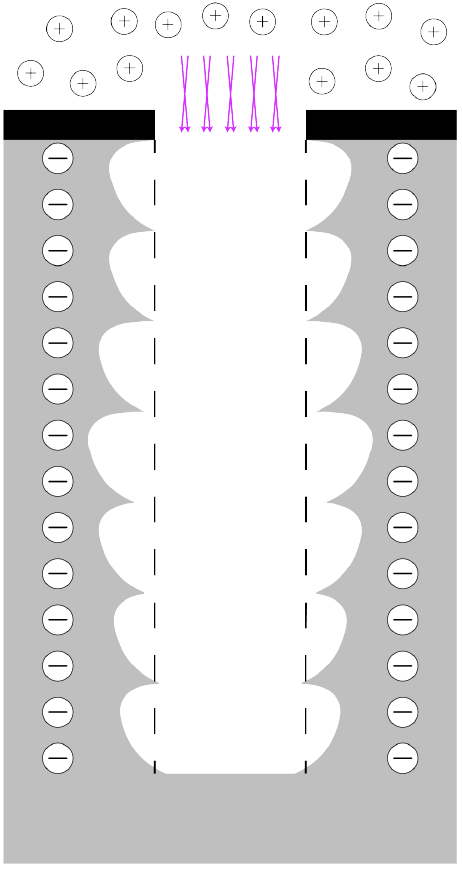
Figure 9. A schematic illustrating the changes in scallop dimensions and location inside the trench sidewall, thereby creating local widening in the middle of the trench (bottling effect) which is caused by a low platen power (CCP) setting and the IF. The IF electro-statically attracts the positively charged ions towards the sidewalls of the trench, changing the area at the bottom of the trench where FC is removed prior to the etch of the next scallop. The starting location of the next scallop moves more into the bulk, as is also depicted in Figure 5. This will result in a local widening of the trench ad/or a negatively tapered trench